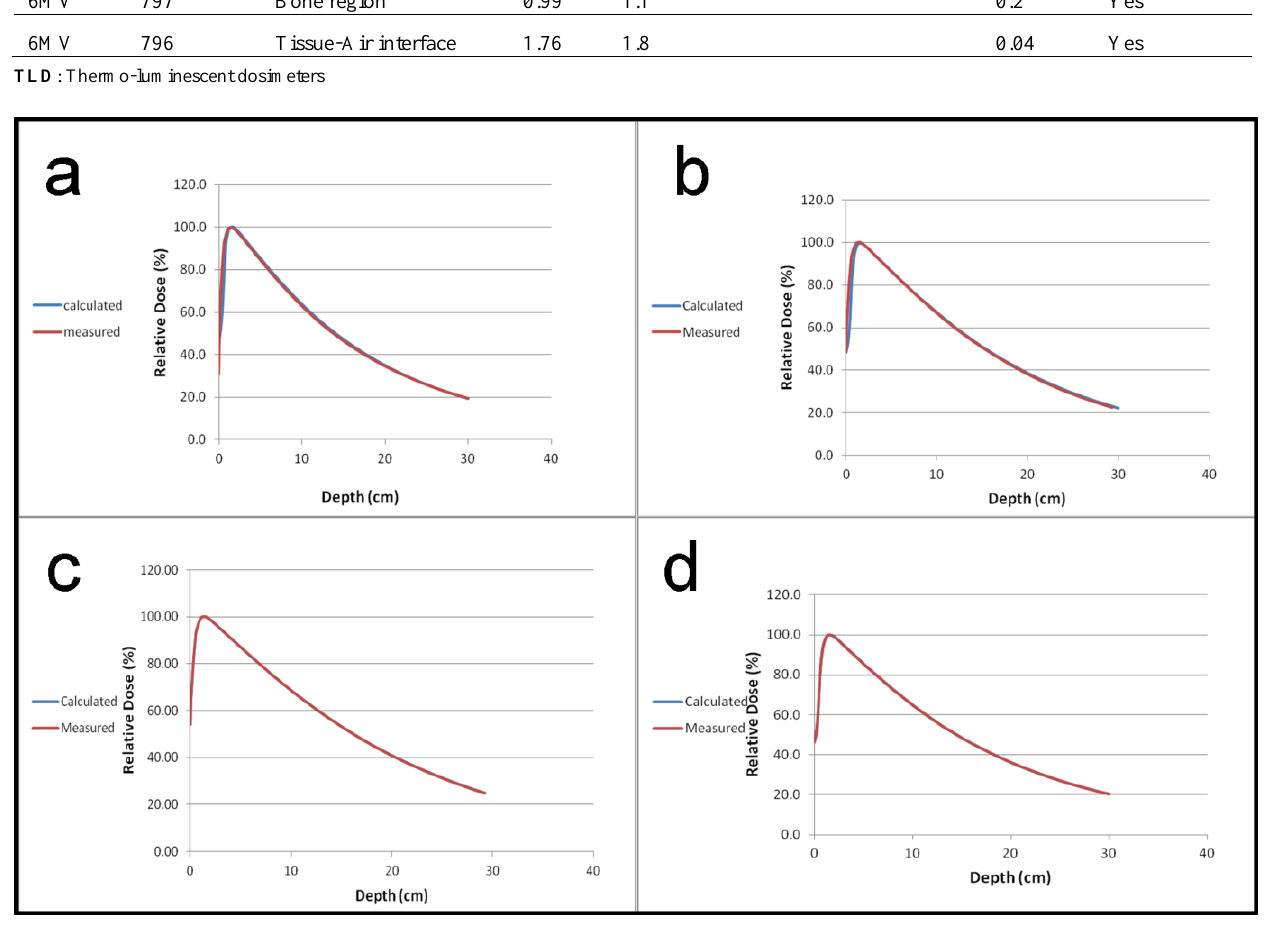
Figure 1. Measured and calculated percentage depth dose for field sizes: a) 5x5 cm 2 at SSD = 100 cm, b) 10x10 cm 2 at SSD = 100 cm, c) 15x15 cm 2 at SSD =100 cm and d) 25x25 cm 2 at SSD =100